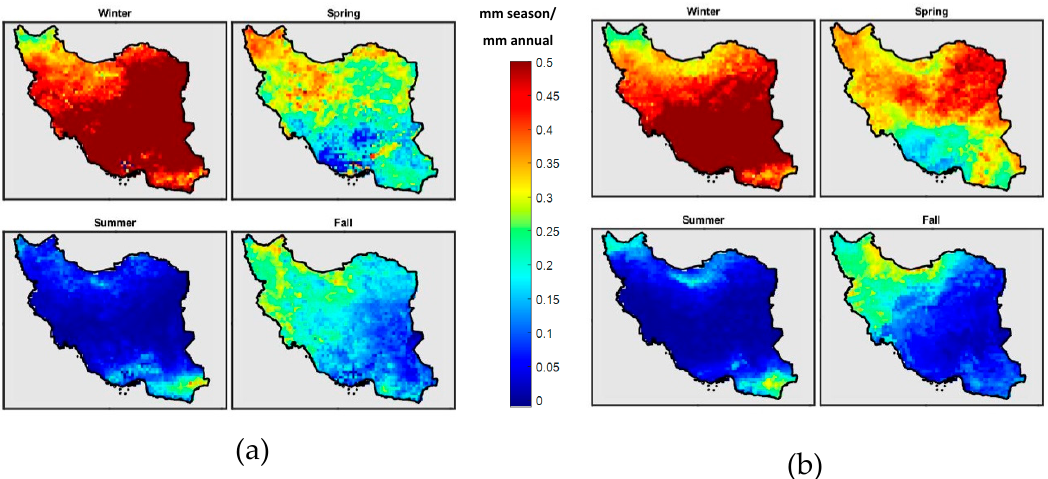
Figure 5. Spatial contribution map for each season in annual precipitation based on climate data record of PERSIANN-CDR for ( a ) dry and ( b ) wet years.